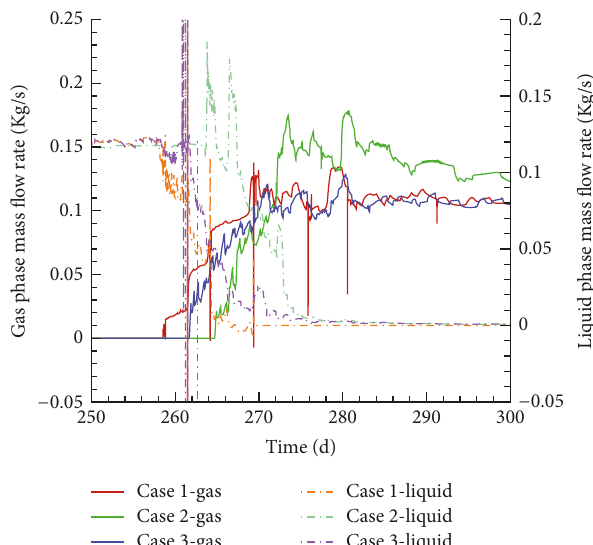
Figure 14: Fluids dynamics in Cases 1 to 3 at the interface of Aquifer 4 and the fracture with CO 2 breakthrough.